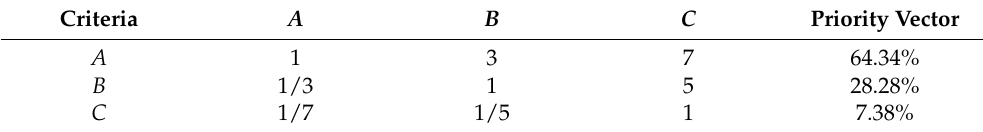
Table 3. Paired comparison matrix.